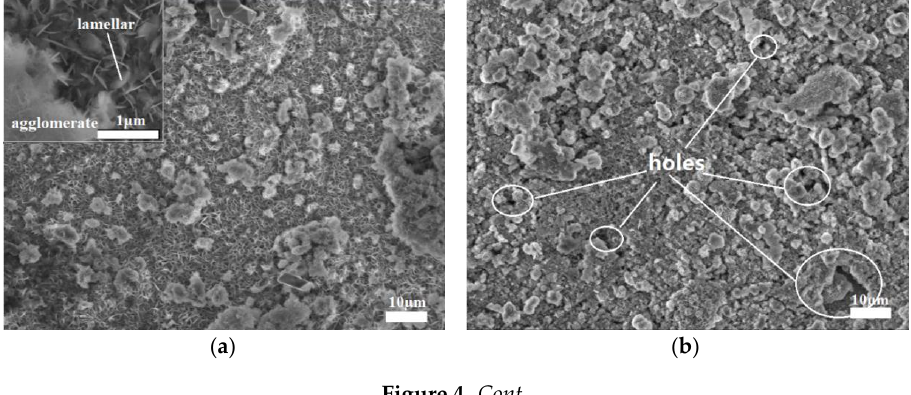
Figure 3. The surface macro-morphology of the four Zn-Al-Mg-TiO 2 coating samples immersed in dynamic salt water for 144, 240, 480, and 720 h respectively.